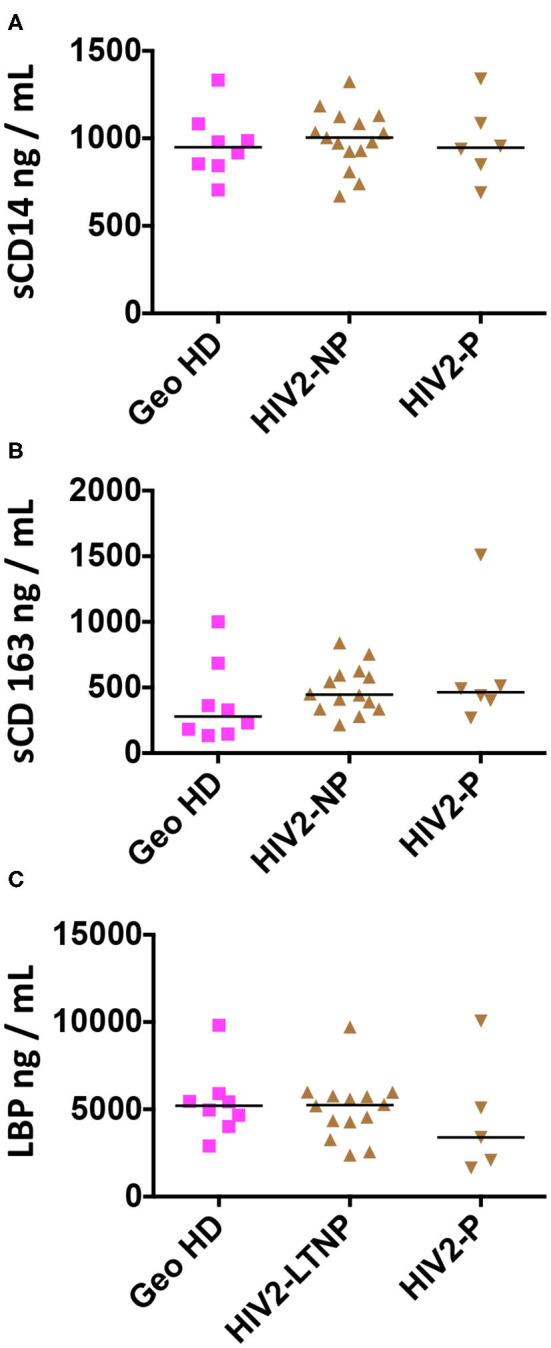
Plasma concentrations of sCD14, sCD163 and LBP in HIV-2-infected participants and uninfected controls (GeoHD), all of West African origin. Plasma concentrations of (A) sCD14, (B) sCD163, and (C) LBP. Horizontal bars represent median values. Kruskall-Wallis test and descriptive statistics can be found in Table 4.